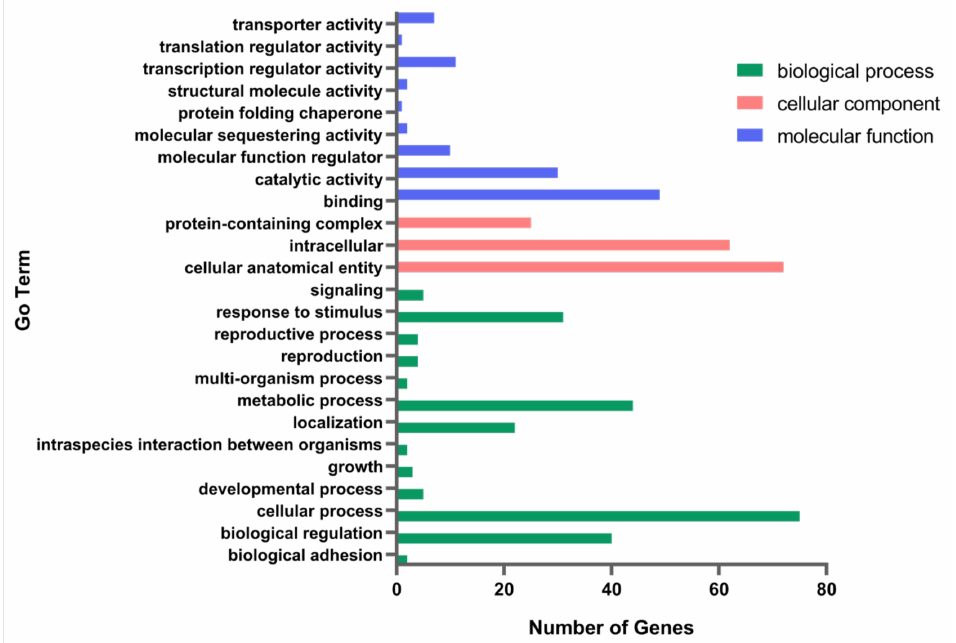
Figure 3. Pathway enrichment of differentially expressed genes between A9- MET4 and the starting strain A9 with Gene Ontology (GO)